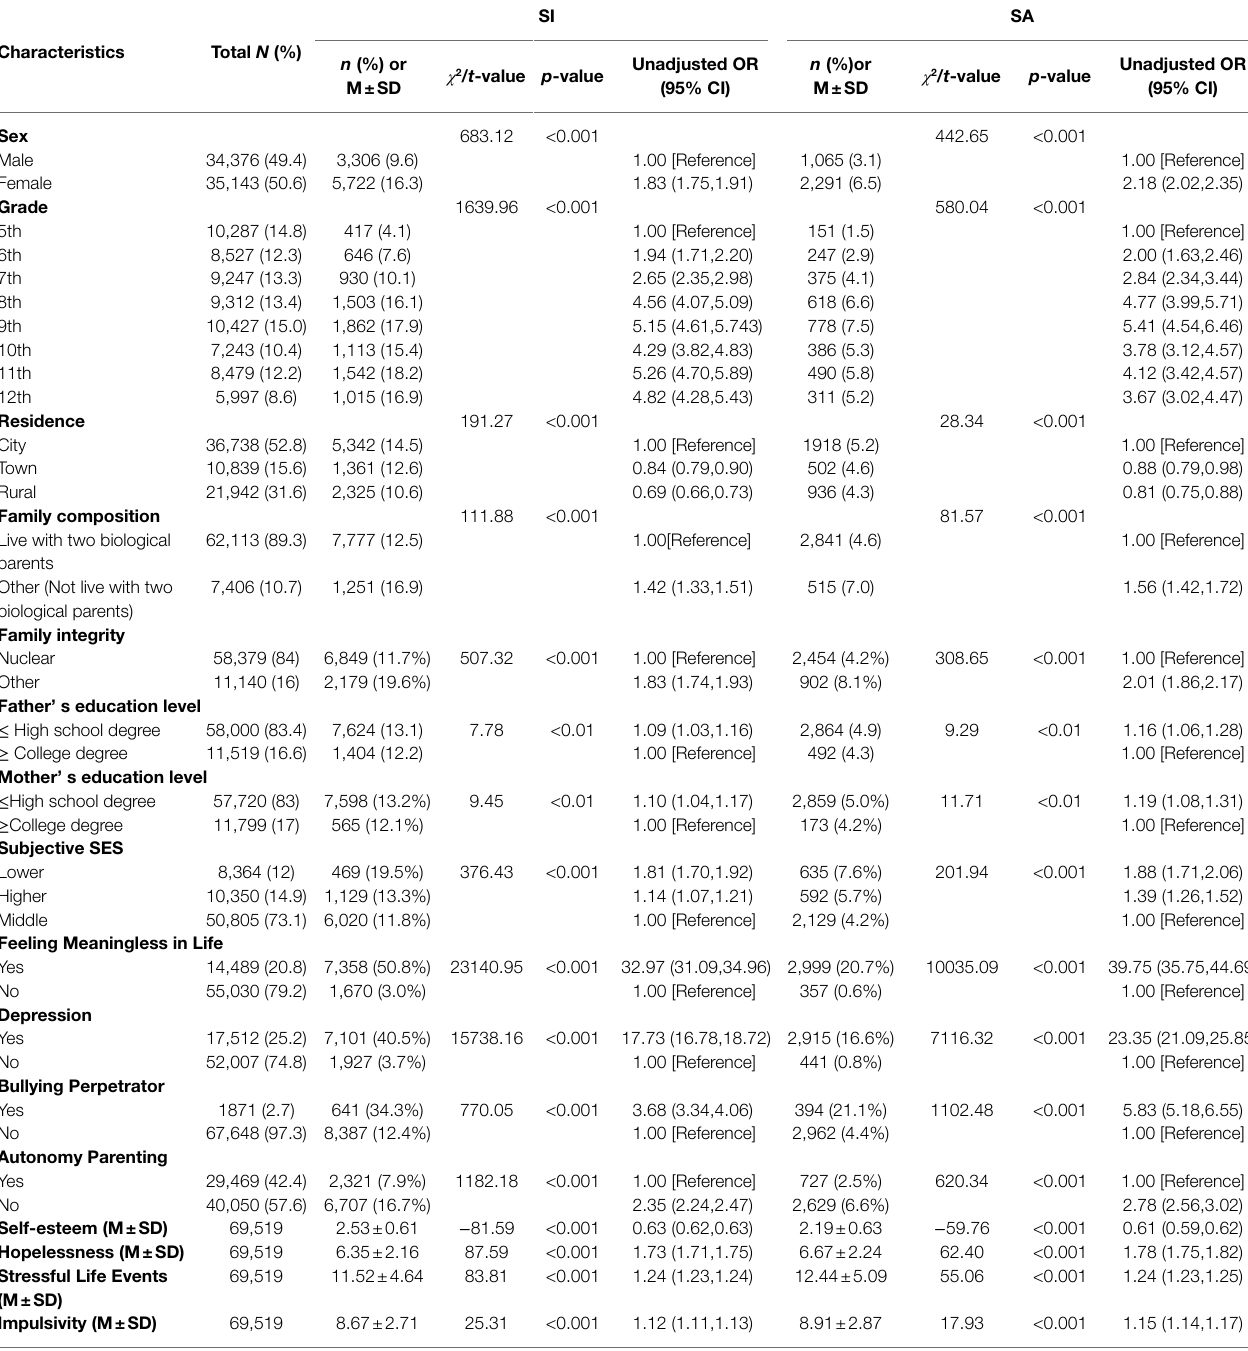
TABLE 2 | Demographic characteristics of participants and regression analysis (unadjusted estimates) by SI and SA of the participants.